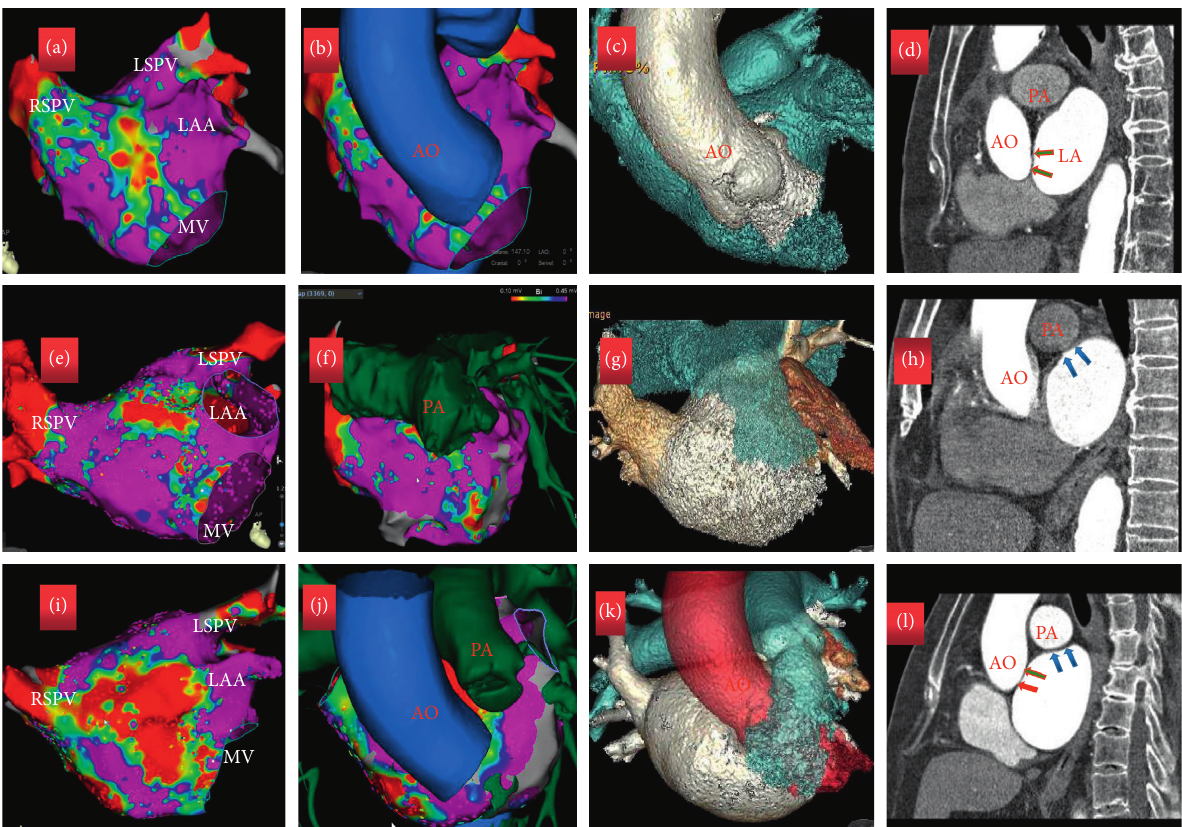
Figure 3: Fusion of the voltage map and the enhanced cardiac CT. Low-voltage area on the LAAW at the left atrium (LA)-aorta (Ao) (a–d) or LA-pulmonary artery (PA) (e–h) or both (i–l) contiguity. The three-dimensional (3D) electroanatomic voltage maps in anteroposterior views (a, e, i) and merged (b, f, j) with 3D enhanced cardiac computed tomography (CT) (c, g, k) corresponding images of enhanced cardiac CT (d, h, l). Ao: aorta; LA: left atrium; PA: pulmonary artery; LAA: left atrial appendage; MV: mitral valve; LSPV: left superior pulmonary vein; RSPV: right superior pulmonary vein.